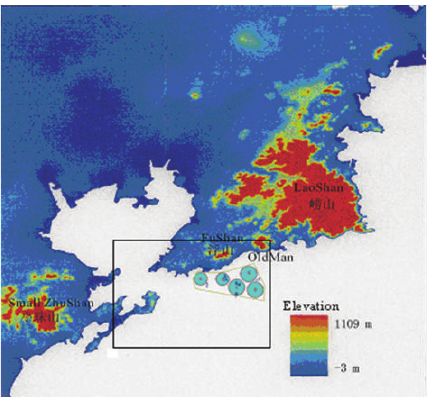
Figure 1: Topography around Qingdao OPSC venues. The region of rectangle is the position of observational system.